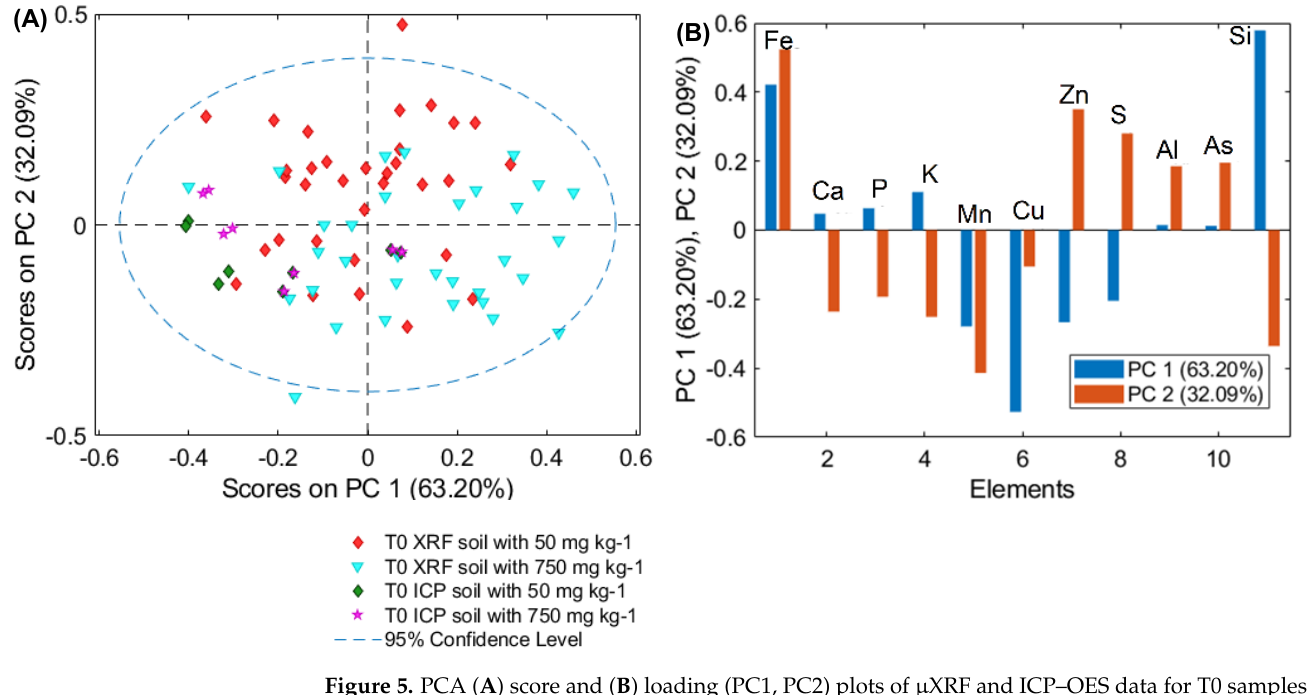
Figure 5. PCA ( A ) score and ( B ) loading (PC1, PC2) plots of µXRF and ICP–OES data for T0 samples for plants grown on soil S1, S2.